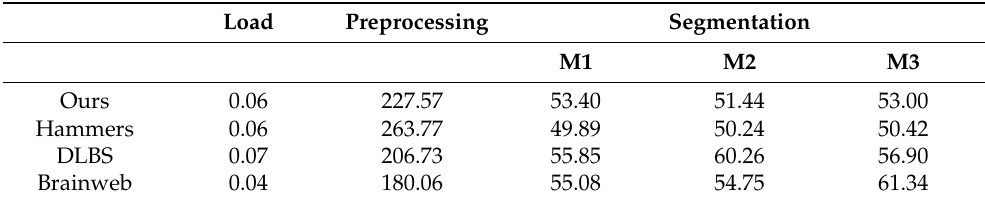
Table 6. Mean times for loading, preprocessing, and segmentation processes. From left to right column are presented: dataset names, load times, preprocessing times, and segmentation time for M1, M2 and M3. The time is expressed in seconds (s). Load Preprocessing